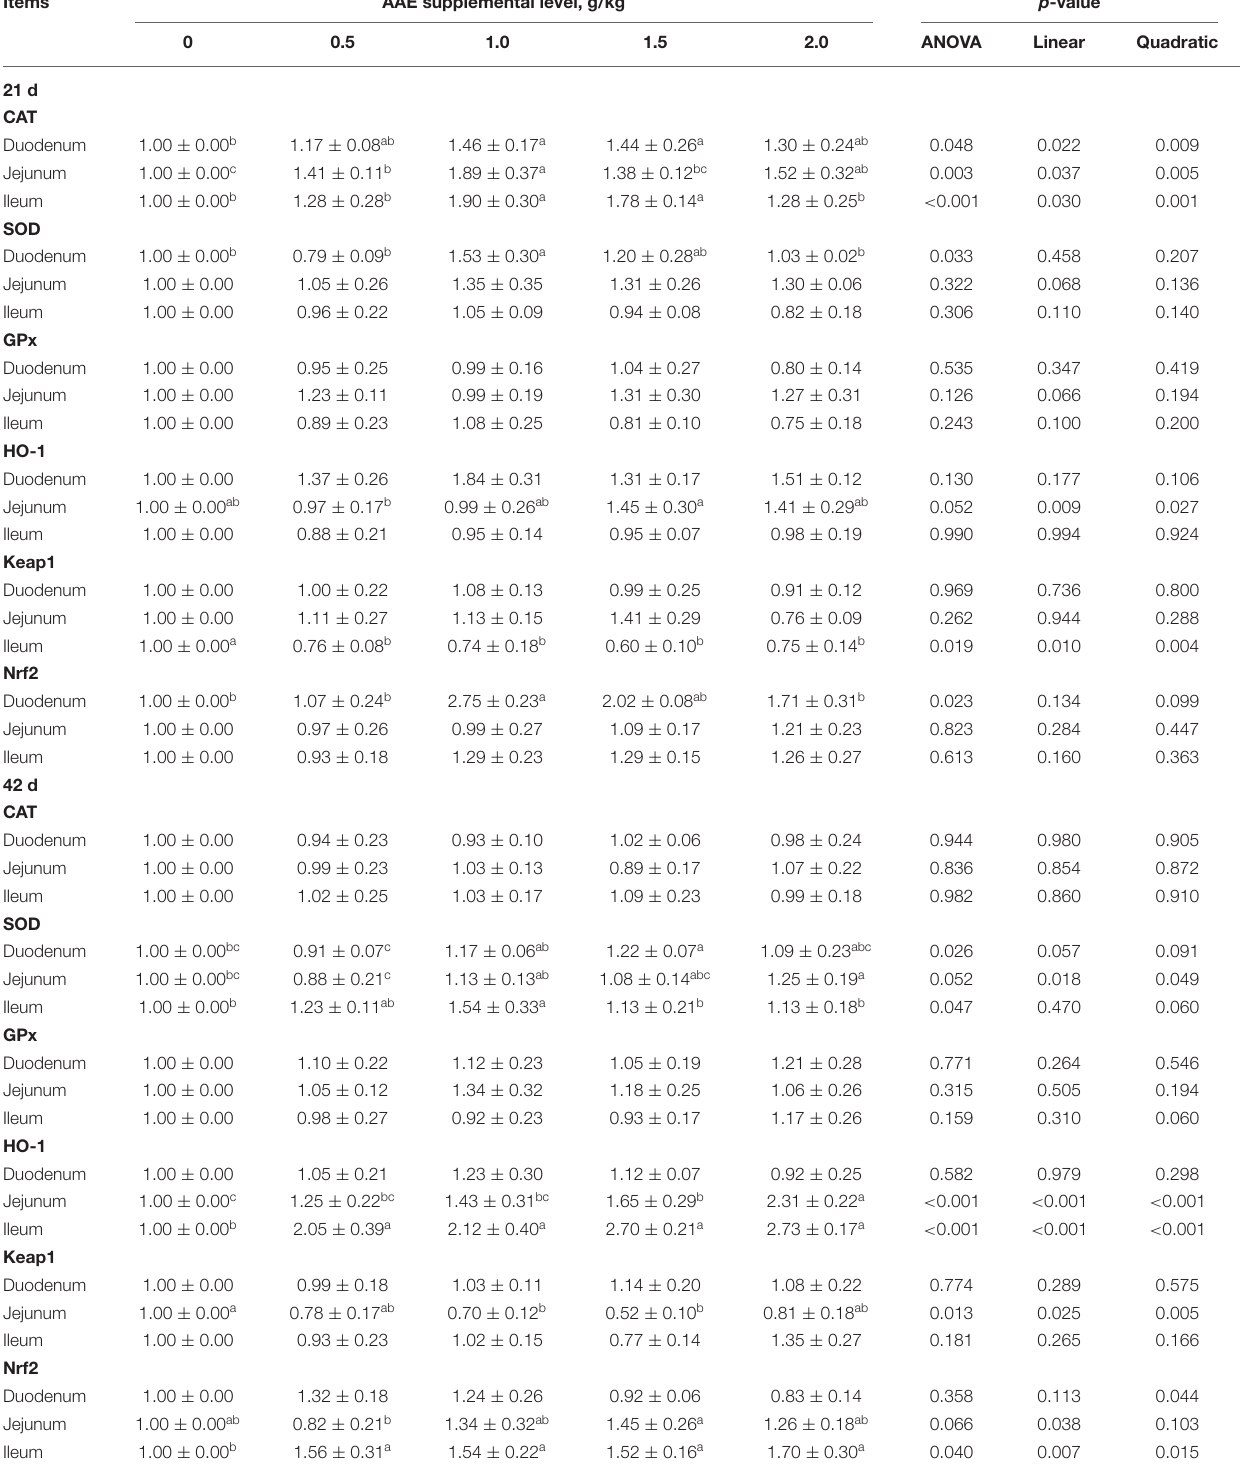
TABLE 8 | Effect of AAE on the expression of small intestinal antioxidant-related genes in broilers.